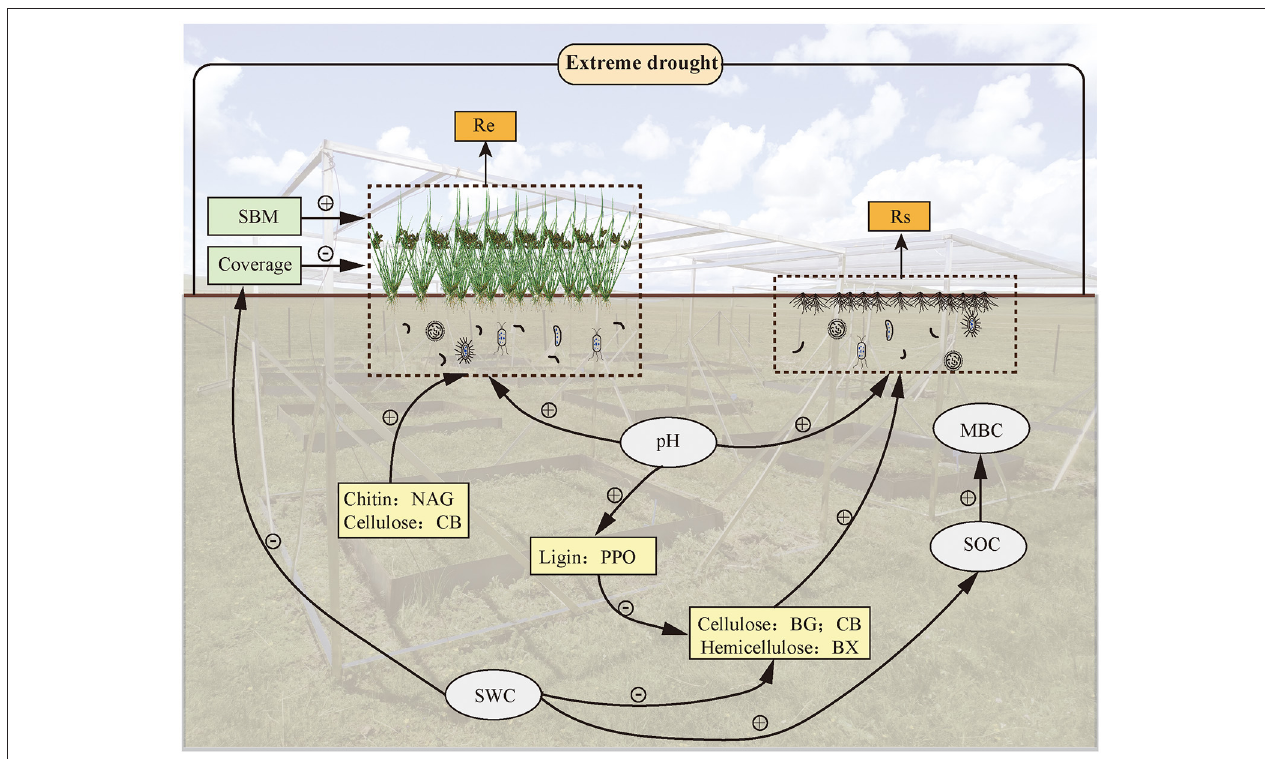
FIGURE 6 | A conceptual framework outlining the direct effects of soil EEAs, soil physicochemical properties, and plant variables on ecosystem C dynamics under extreme-drought